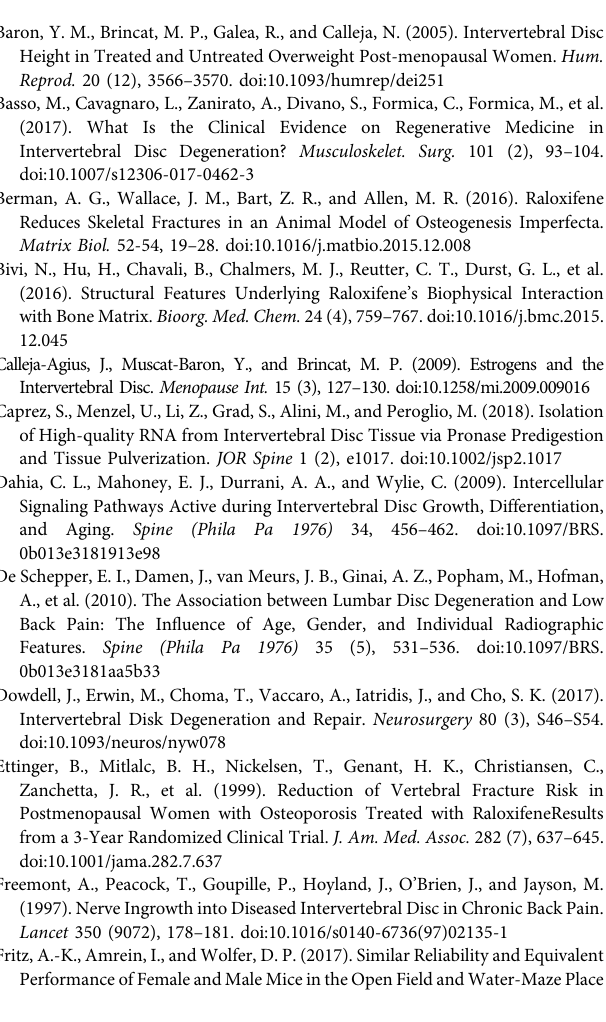
Supplementary Figure S6 | Raloxifene improved the AF and NP structure of lumbarIVDsinyoungandoldmice.5xrepresentativelumbarSafranin-O/FastGreen